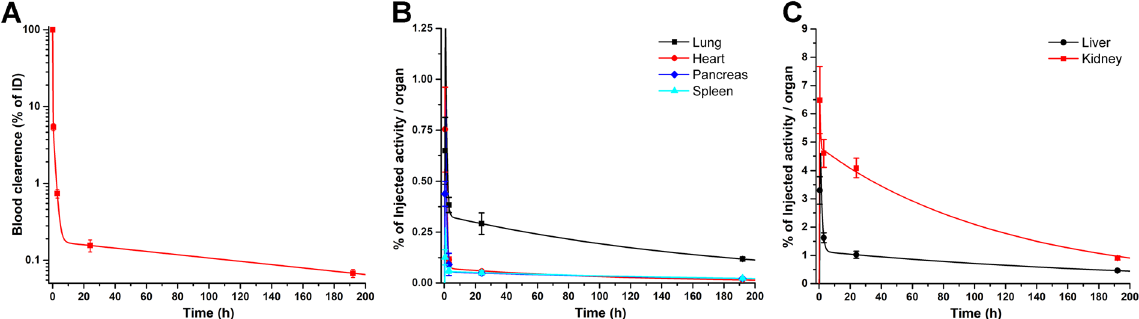
Figure 5. ( A ) 177 Lu-scFvD2B blood clearance. ( B ) Biokinetic curves of non-target organs with rapid clearance. ( C ) Biokinetic curves of non-target organs with slower clearance.